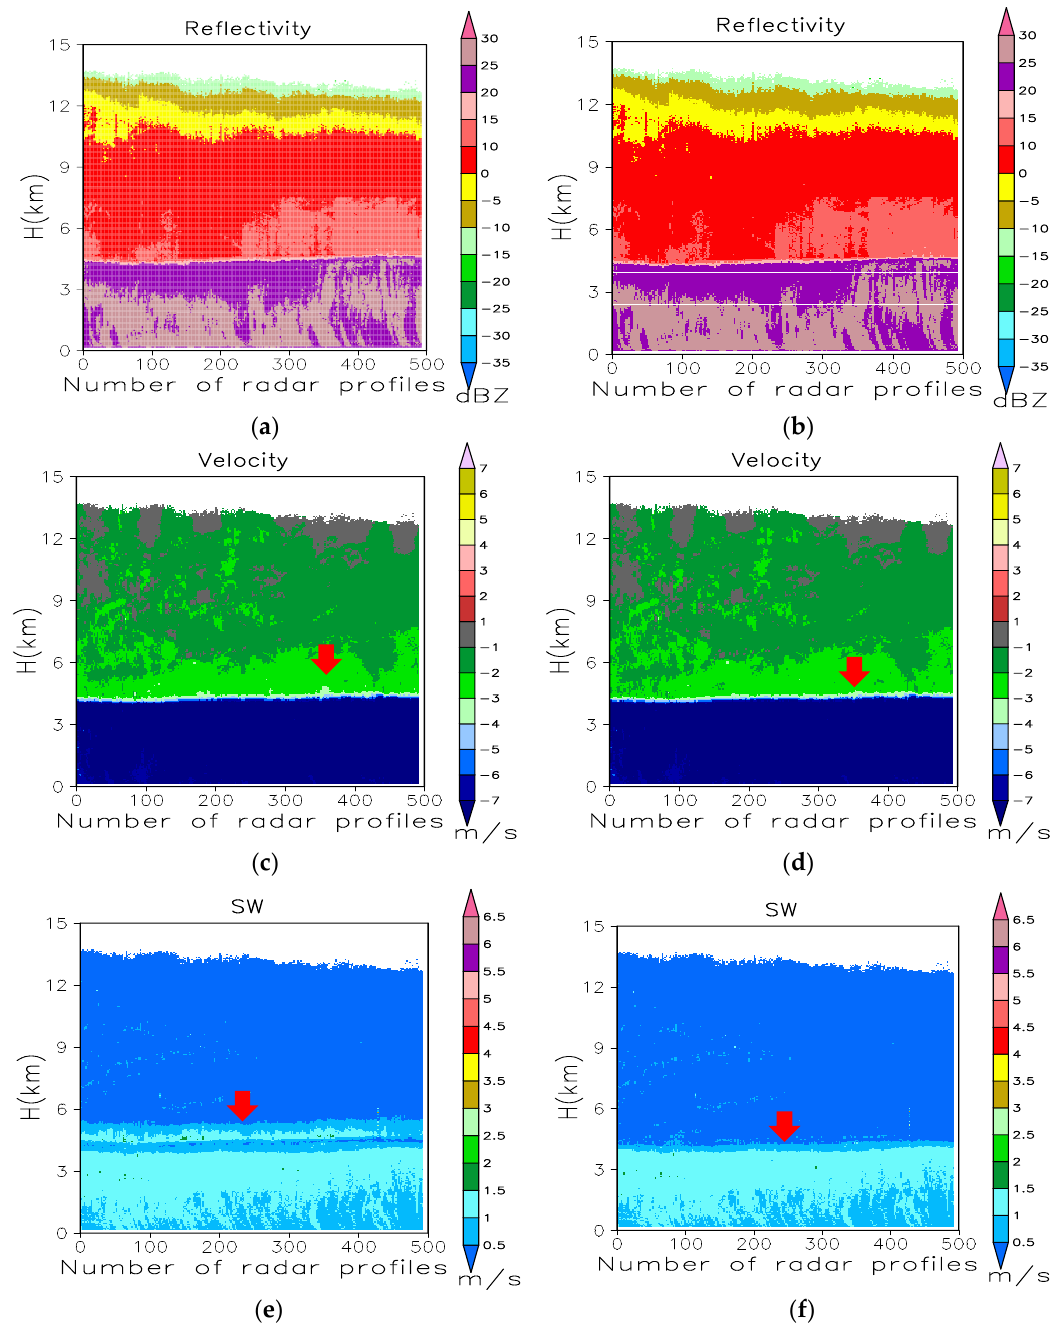
Figure 9. Recalculated ( a ) reflectivity, ( c ) radial velocity, and ( e ) spectrum width only after dealiasing. The corresponding results ( b ), ( d ), and ( f ) after dealiasing and artefact removal from SZ2. The biases of velocity and spectral width introduced by range sidelobe artefacts are shown with the red arrows in ( c ) and ( e